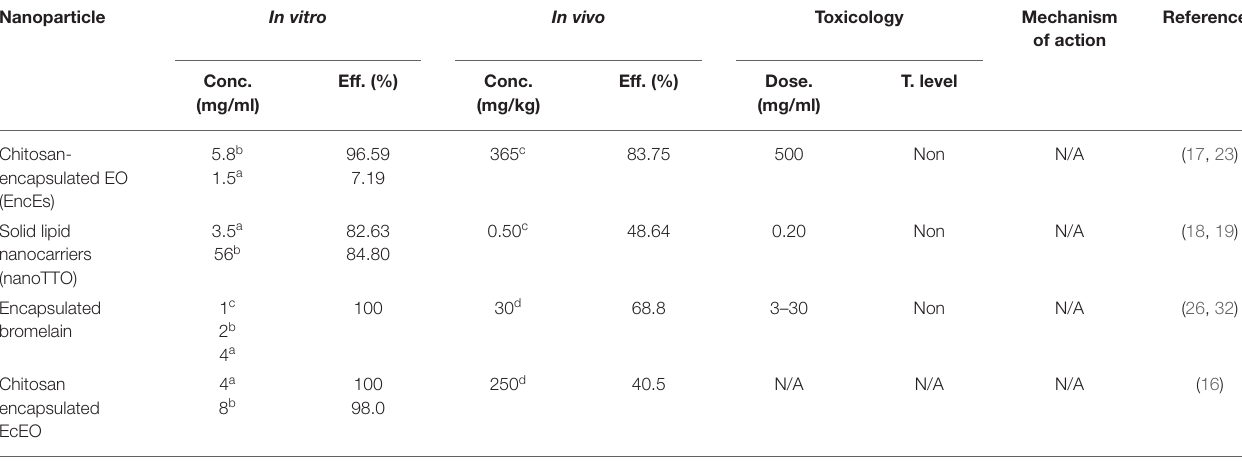
TABLE 4 | Comparative analysis of common nanoparticles used against H. contortus . Nanoparticle In vitro In